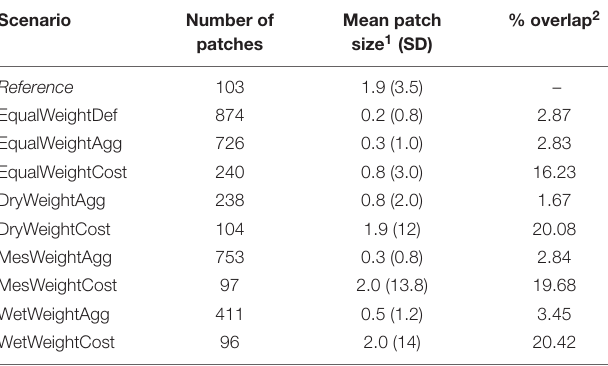
TABLE 5 | Basic landscape-ecology metrics for retention patches under the various scenarios (see Table 4 ).